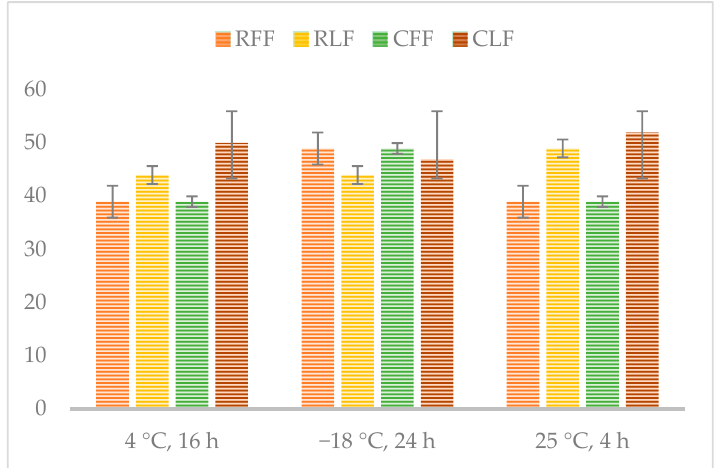
Figure 3. Freeze-thaw stability of pudding formulations (RFF—rice starch, peach purée; RLF—rice starch, lyophilized fruit; CFF—corn starch, peach purée; CLF—corn starch, lyophilized fruit).